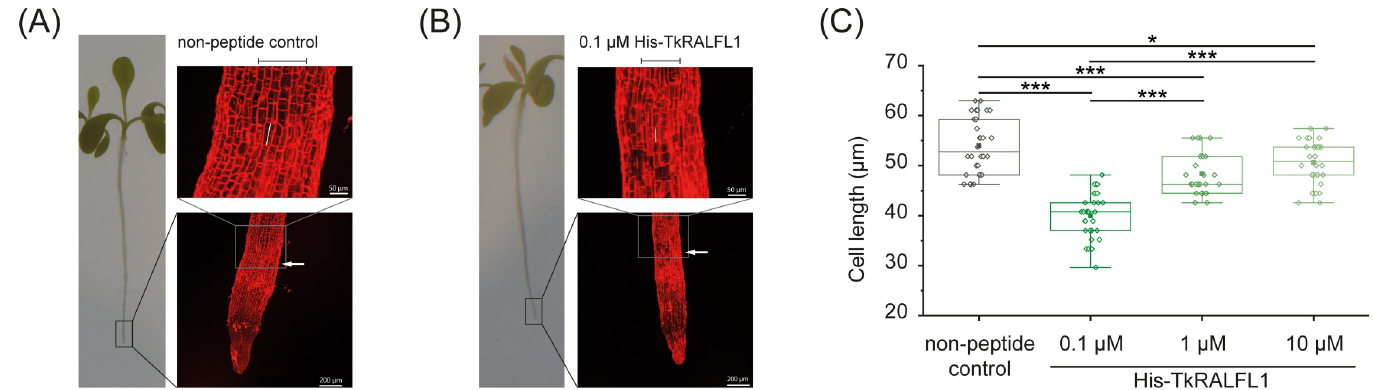
Fig 3. Detailed analysis of primary root cell length after treatment with TkRALFL1. (A) Root tip image acquired by CLSM of a representative seedling treated for 10 days with non-peptide control. Seedlings were stained with propidium iodide (0.1 mM). The white arrow indicates the distance of 1 mm from the very tip; scale bar as indicated in the respective images; the black bar above the magnified segment indicates the most inner six rows of rhizodermal cells measured for evaluation of the cell length, one cell is exemplarily marked by a white bar. (B) Root tip image of a representative seedling treated for 10 days with 0.1 μ M His-TkRALFL1 as described in Fig 3A. (C) Cell length of rhizodermal cells from root tips of seedlings treated for 10 days with different concentrations of TkRALFL1 as indicated. n = 30, normal distribution proved by Kolmogorov-Smirnov test, statistical significance proved by two-tailed t -test, � p < 0.05, ��� p < 0.001. Box plot as described in Fig 2.